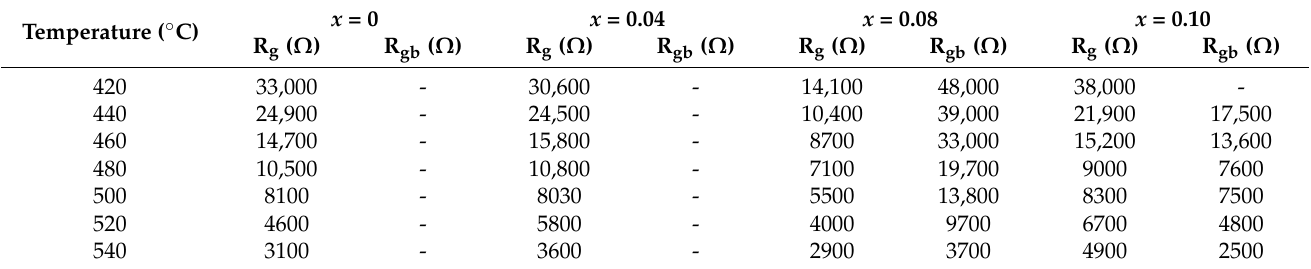
Figure 6. Arrhenius plots and fitting results as well as corresponding activation energy of grain conductivity for KNNS x -BNN ceramics.